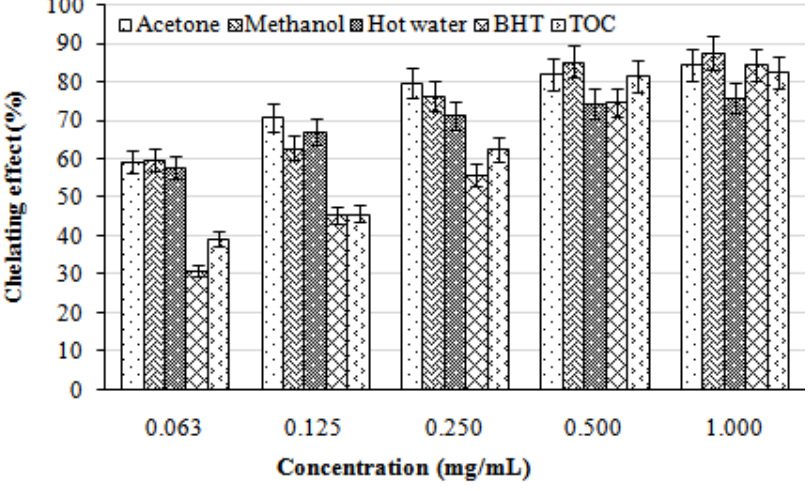
Figure 2. Chelating effect of various extracts from the fruiting bodies of Lentinus lepideus . Values expressed as means ± SD (n = 3); BHT, butylated hydroxytoluene; TOC, α -